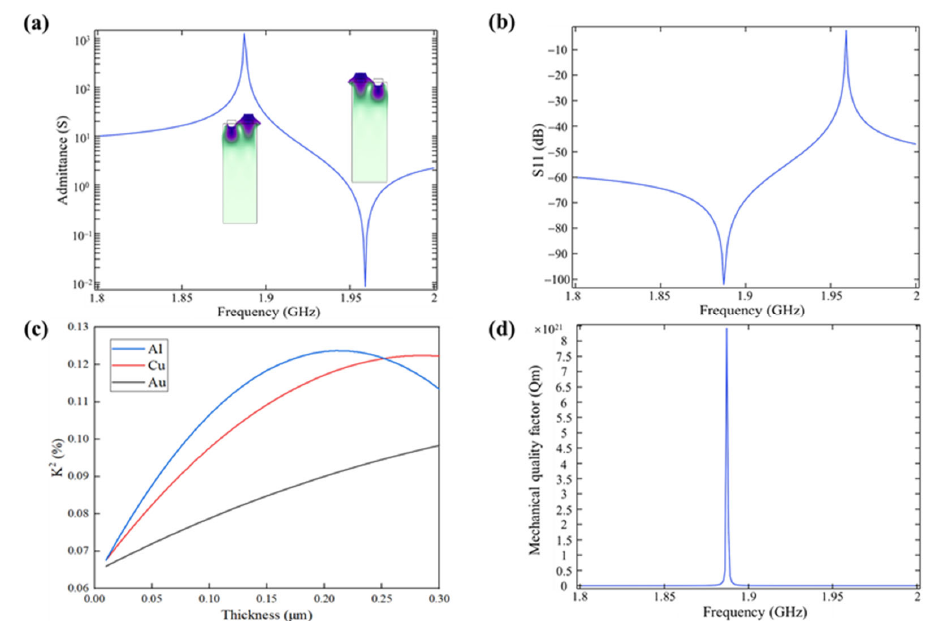
Figure 3. Parameter characteristics of the SAWS. ( a ) The admittance curve of the SAWS under the initial condition (the figure shows the deformed shape of the SAW when it is excited); ( b ) the S11 parameter of the SAWS is expressed in decibels; ( c ) variation curve of electromechanical coupling coefficient with electrode thickness when gold, copper, and aluminum are used as electrodes; ( d ) Q m parameter curve of SAWS.